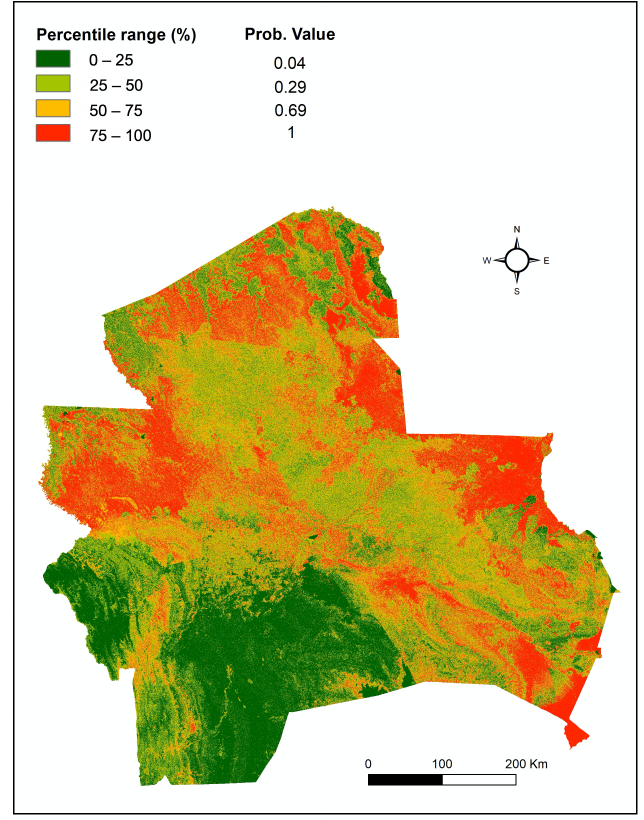
Figure 7. Wildfire susceptibility map of Santa Cruz.